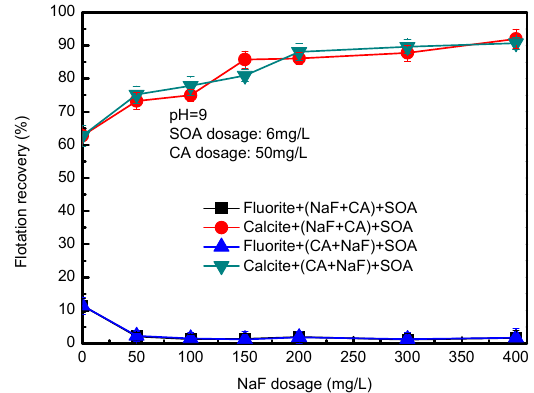
Figure 6. Effect of NaF dosage and order of addition of NaF and CA on flotation recoveries of calcite and fluorite minerals using SOA as the collector and NaF + CA as the depressant. (NaF + CA denotes the adding order of NaF and then CA; CA + NaF denotes the adding order of CA and then NaF).